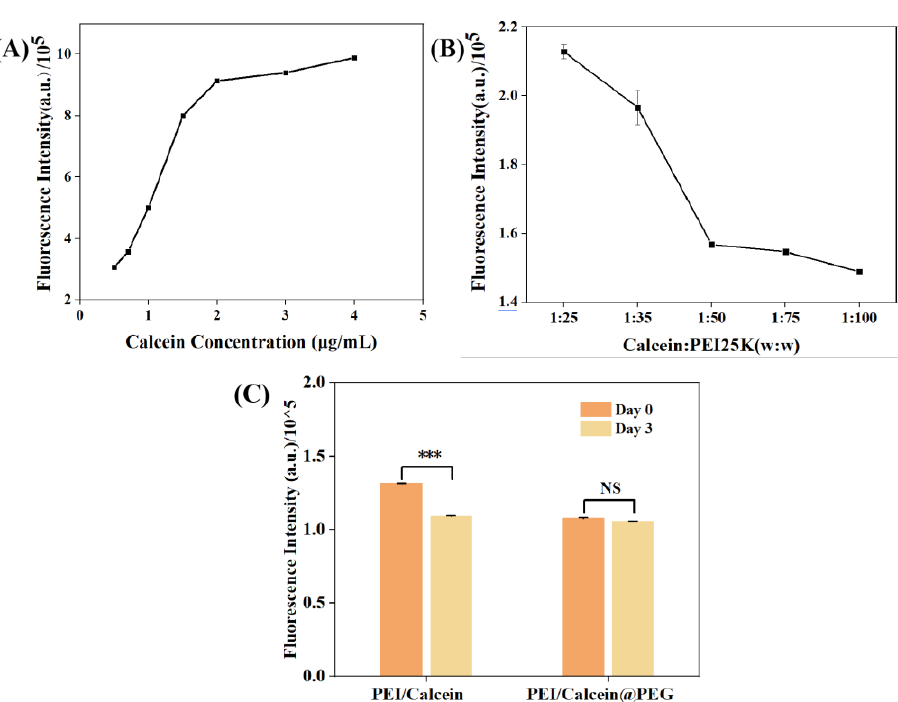
Figure 7. ( A ) Relationship between Calcein concentration and fluorescence intensity. ( B ) Fluorescence values of PEI/Calcein complex at different ratios. ( C ) Fluorescence intensity of PEI/Calcein and PEI/Calcein@PEG, Calcein: PEI = 1:50 ( w : w ), n = 3, *** p < 0.001, not significant (NS).